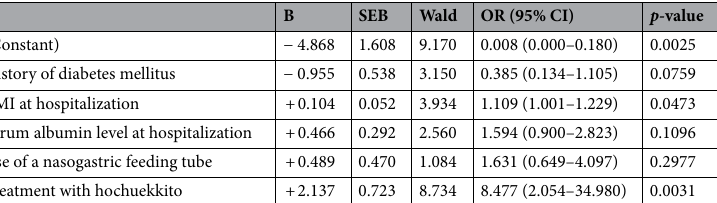
Table 3. Binary logistic regression analysis for the subsequent achievement of VRE negative conversion. All independent variables were treated as ordinal variables. OR = exp(B), Wald χ 2 statistics (Wald) = ( B / SEB ) Wald is a marker of the significance of each coefficient in the applied predictive model. B unstandardized partial regression coefficient, BMI body mass index, CI confidence interval, OR odds ratio, SEB standard error of the coefficient, VRE vancomycin-resistant